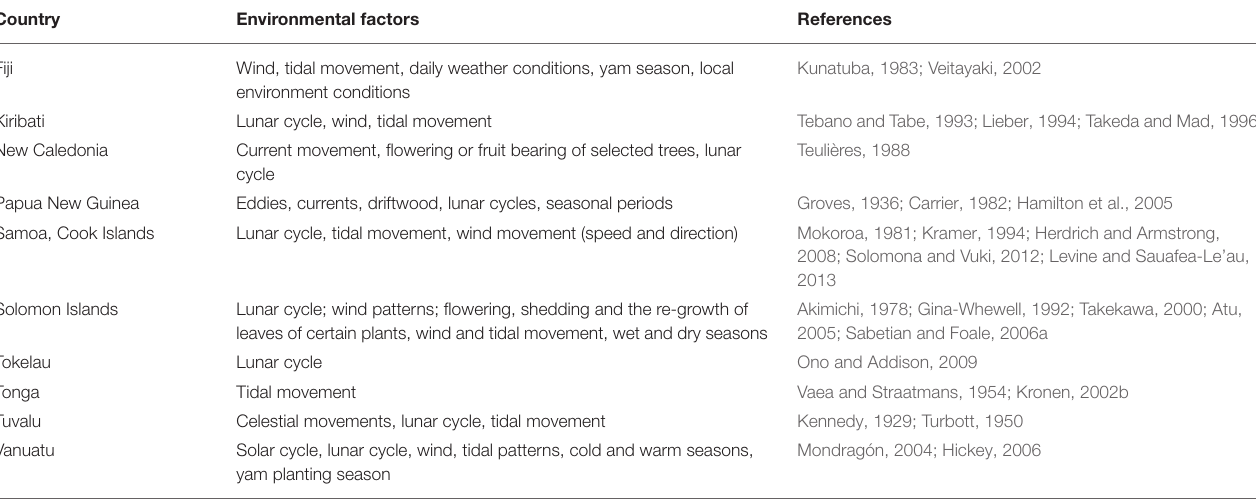
TABLE 1 | Environmental factors, which influence indigenous fishing decisions on the type of gear, fishing methods and techniques which they use on a given fishing expedition, in Fiji and other Pacific Islands.